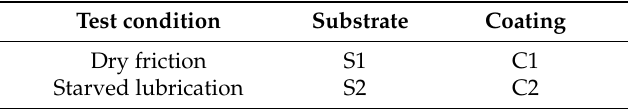
Table 2. The names of samples under different test conditions.